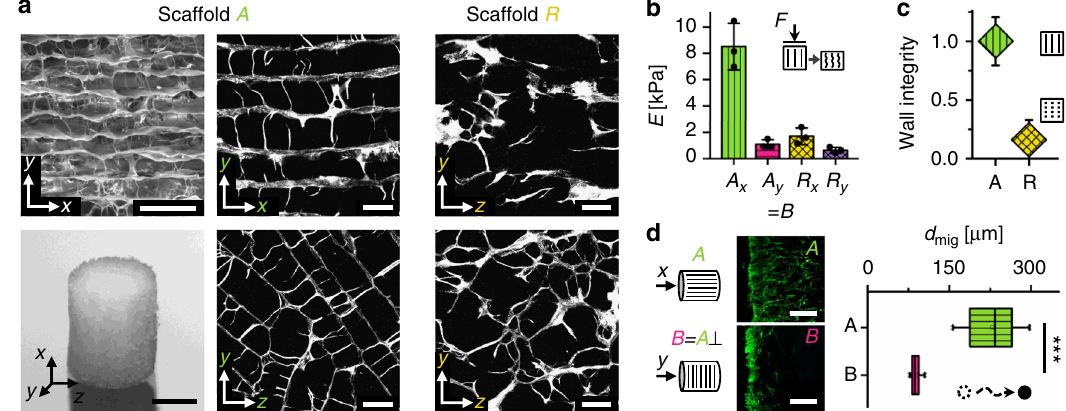
Fig. 2 Scaffold pore architecture guides cell migration in vitro. a Scanning electron microscopy (SEM) image showing the scaffold pore architecture with highly aligned pores along the x axis (top left). Photograph of the scaffold as used in vitro (5 mm diameter, 3 mm height) (bottom left). SHG images of the scaffold pore architecture for aligned scaffolds A and random scaffold R cut along (top middle and right) and perpendicular (bottom middle and right) to the direction of directional freezing during production. b Mechanical stiffness of the prototypes in the two directions shown in a (median ± SD). Characterization was performed on n = 3 technical replicates. c Analysis of pore wall integrity indicating a pronounced reduction of pore wall integrity along the x direction in random scaffold R compared with scaffold A (median ± SD). Characterization was performed on n = 8 individual multiphoton image stacks. A high wall integrity is a characteristic feature of the channel-like pore architecture of scaffold A. d Quanti fi cation of the migration distance d mig for migration of hBMSCs along (scaffold A) and perpendicular (scaffold B) to the pore orientation 3 days after cell seeding. Images on the left show representative cell distribution close to the surface of the scaffold 24 h post seeding (cross-sections stained for F-actin after cell seeding on the base of the scaffold cylinder). Signi fi cance calculated by Mann – Whitney test (two-sided). *** p < 0.001, n = 8 biological replicates (hBMSCs from 8 different donors), n = 2 – 3 technical replicates per donor. Boxplot in d shows the median, 25th and 75th percentile values (vertical bar, left and right bounds of the box), whiskers indicate the 1.5-fold IQR; open squares indicate means; crosses represent maximum/minimum values. Scale bars for a 200 µ m in SEM image, 2 mm in photography, 100 µ m in SHG images; d 250 µ